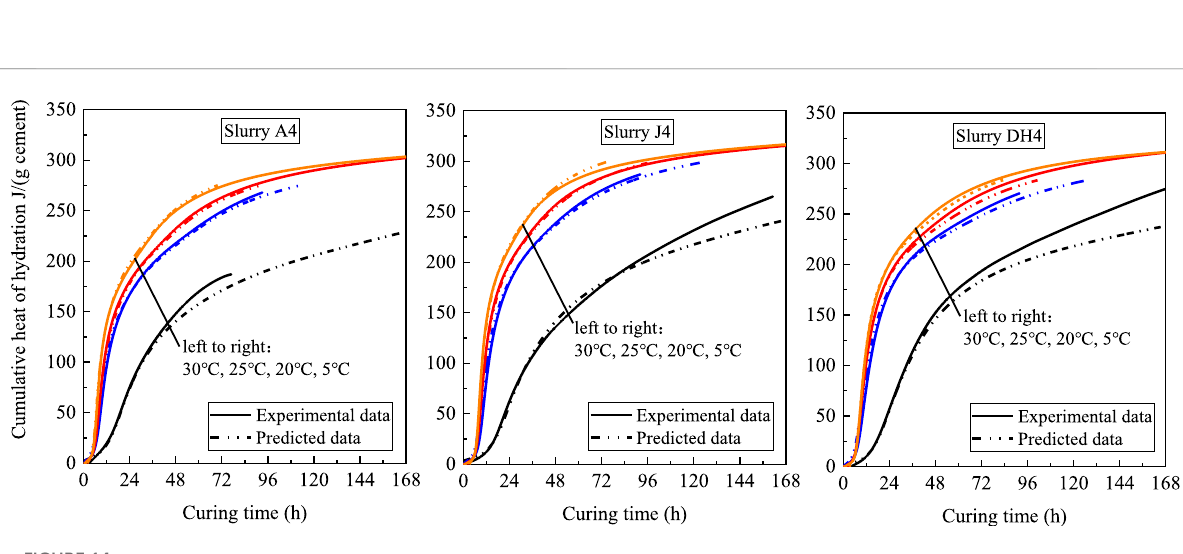
FIGURE 14 Experimental and predicted hydration heat evolution curves of different cements under low temperatures (15 ° C tests as references).